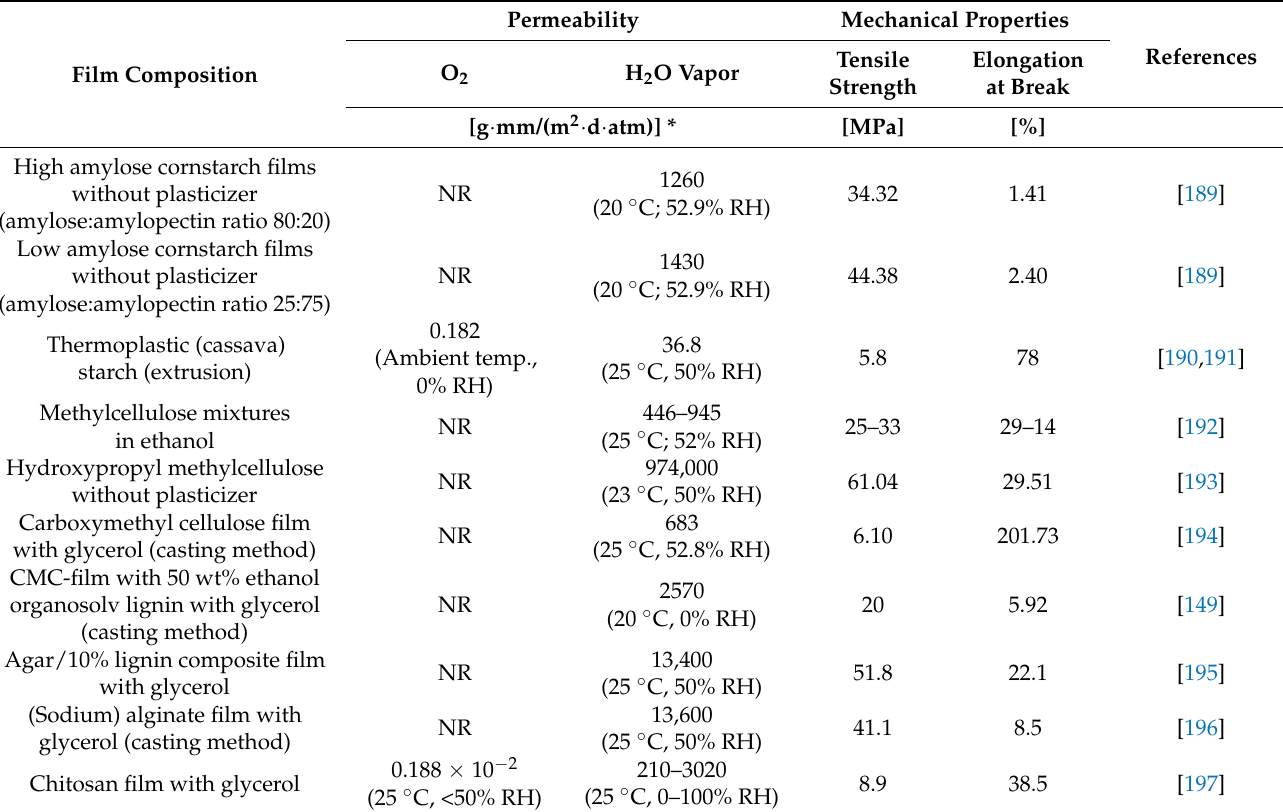
Figure 5. Overview of several polysaccharides used for food packaging (edible) films: ( a ) starch, ( b ) cellulose, ( c ) alginate, and ( d ) chitosan [188]. Table 4. Barrier and mechanical properties of polysaccharide-based